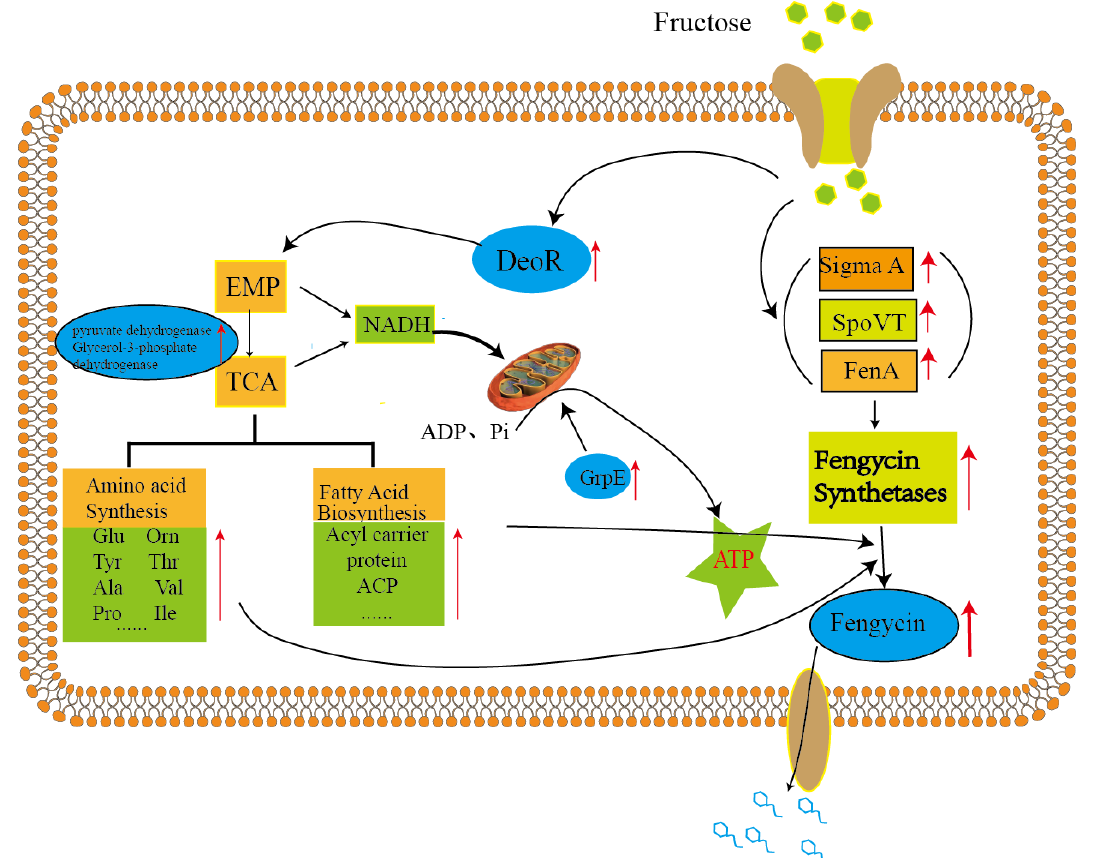
Figure 4. Schematic presentation of pathways of B. amyloliquefaciens fmb-60, which was cultivated in MLF medium is illustrated above. The identified proteins involved in nine different pathways were marked with red (up-regulation) ar- rows.